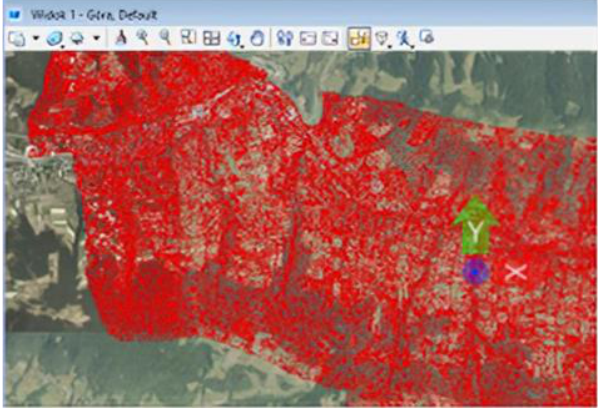
Figure 26. The render of the development area landscape — a view of the Szczebel mountain slope .